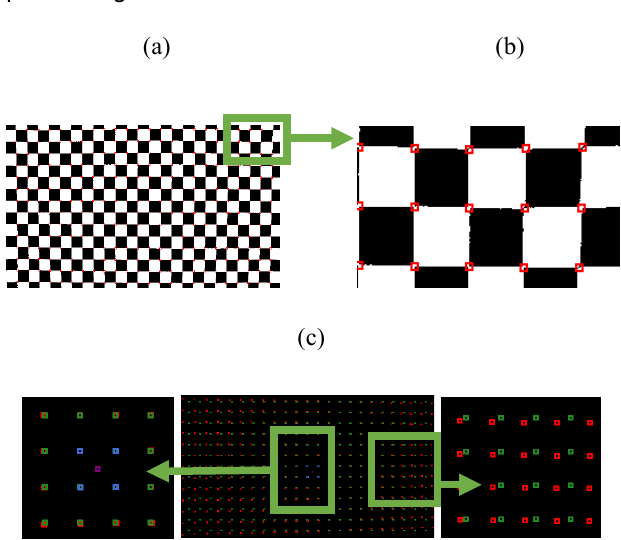
Figure 3. Simplified work flow of the image processing.